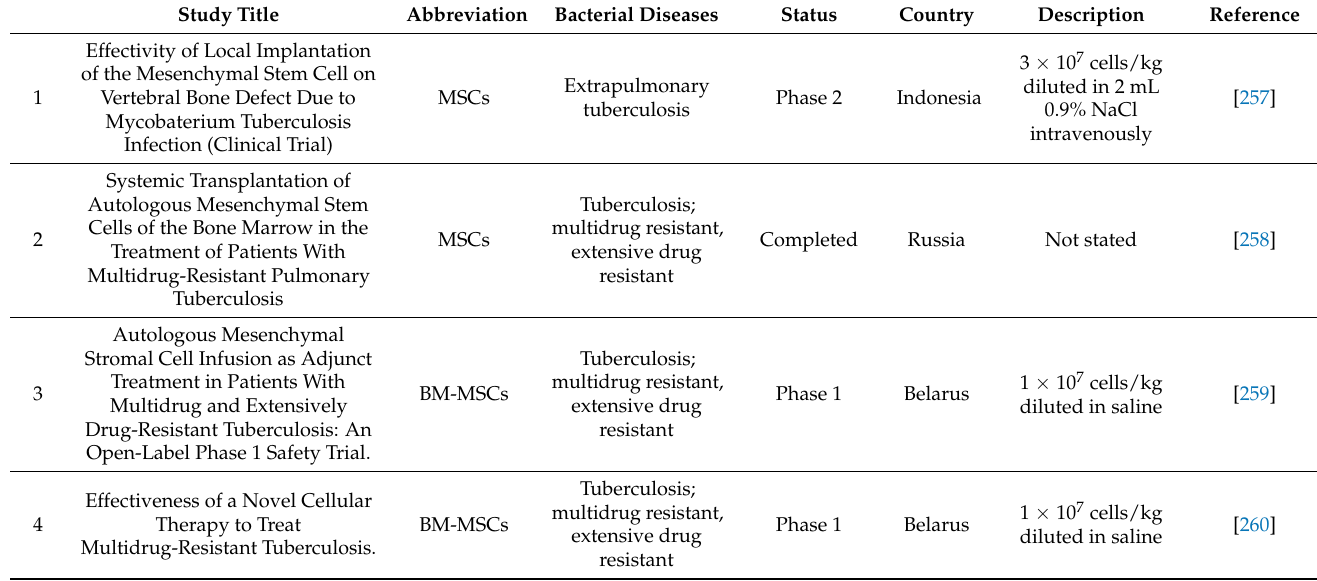
Table 4. MSC- and MSC-EV-based clinical trials of the bacterial infection